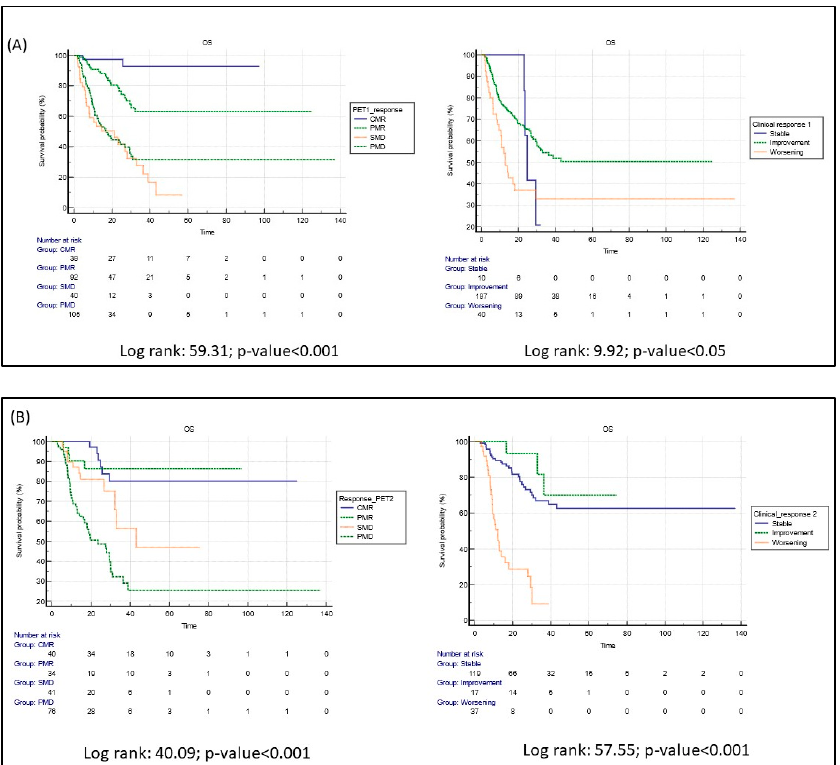
Figure 2. ( A ) Kaplan–Meier curves for OS based on the first PET/CT scan and clinical examination after starting immunotherapy in 276 patients; ( B ) Kaplan–Meier curves for OS based on the second PET/CT scan and clinical examination in 190 patients. CMR = complete metabolic response; PMR = partial metabolic response; SMD = stable metabolic disease; PMD = progressive metabolic disease; Time was expressed in months.